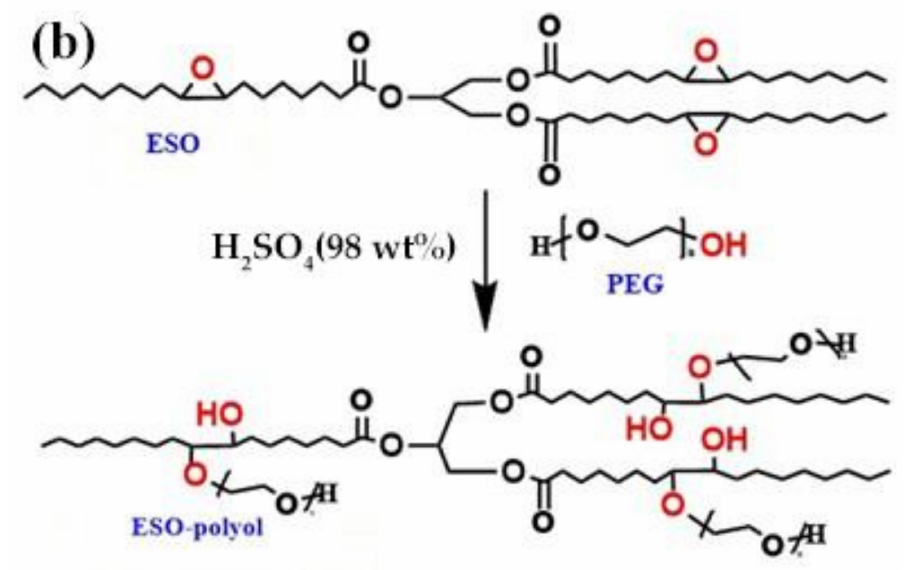
Figure 1. ( a ) Soybean oil-based polyester polyol reaction device; ( b ) soybean oil-based polyester polyol reaction